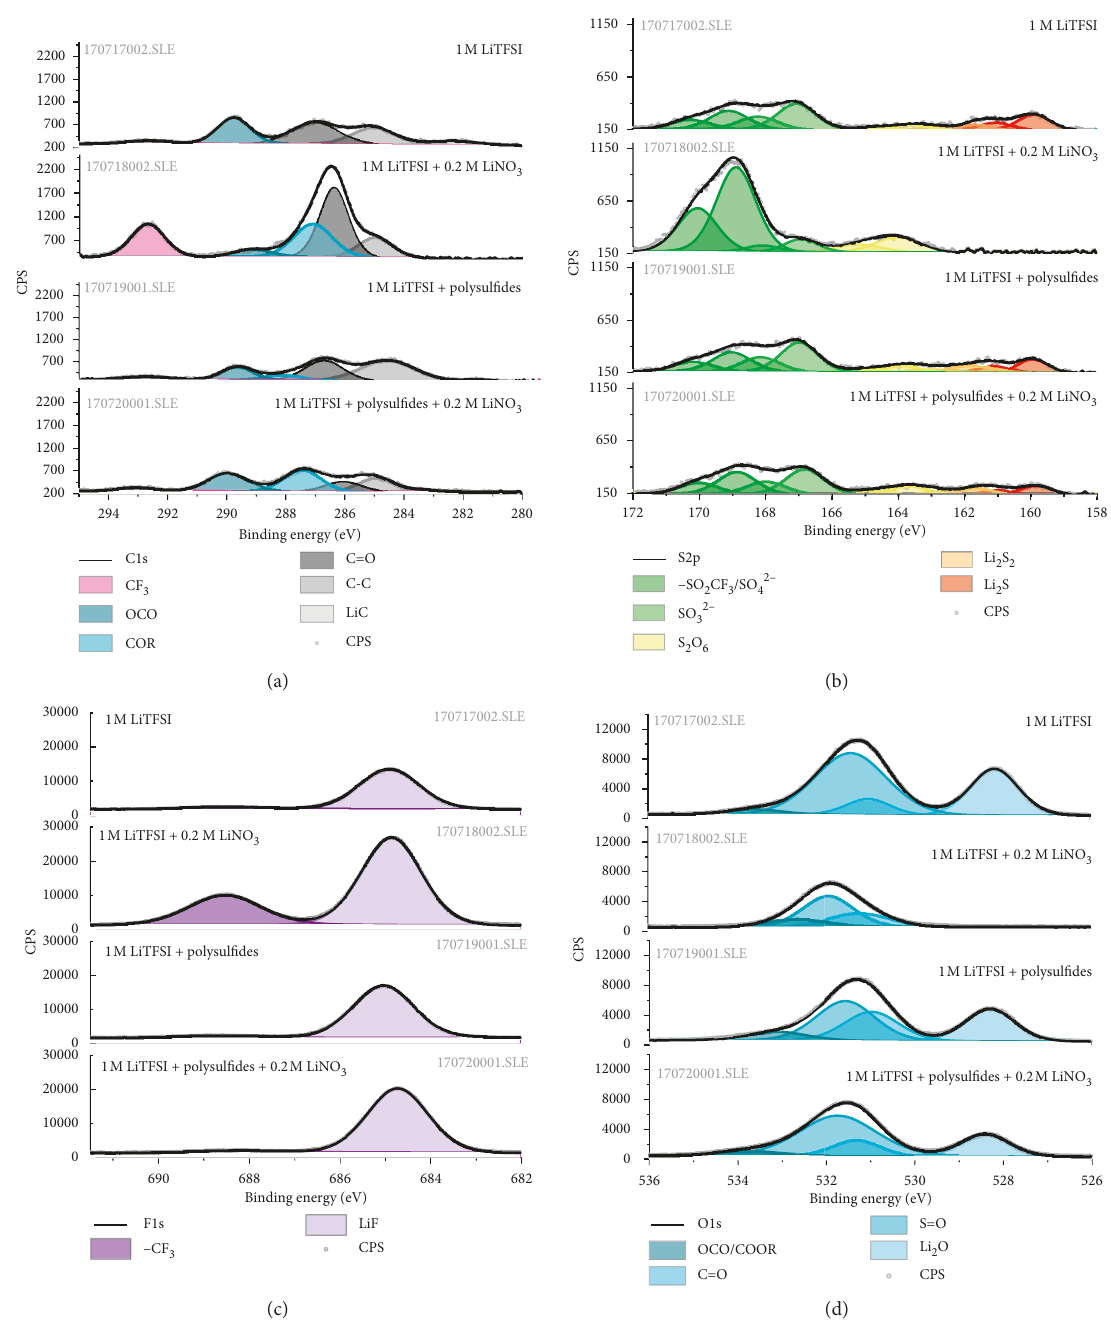
F IGURE 3: C1s (a), S2p (b), F1s (c), and O1s (d) core-level XPS spectra of the SEI layer of all four samples under investigation (see Table 1). The spectra are recorded after 30min sputtering with Ar+. The individual components are presented in different colors. The envelope peaks are colored in black. The spectral intensity is presented as received (in counts per seconds, CPS) without further